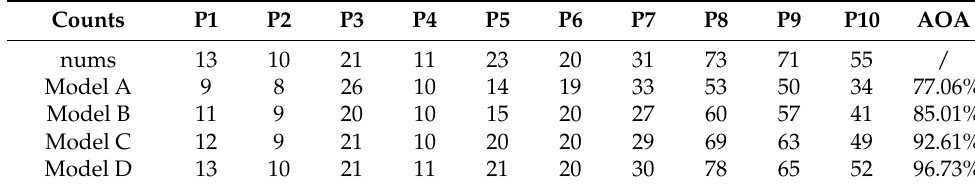
Table 3. The results of fruit tree counts based on different models.